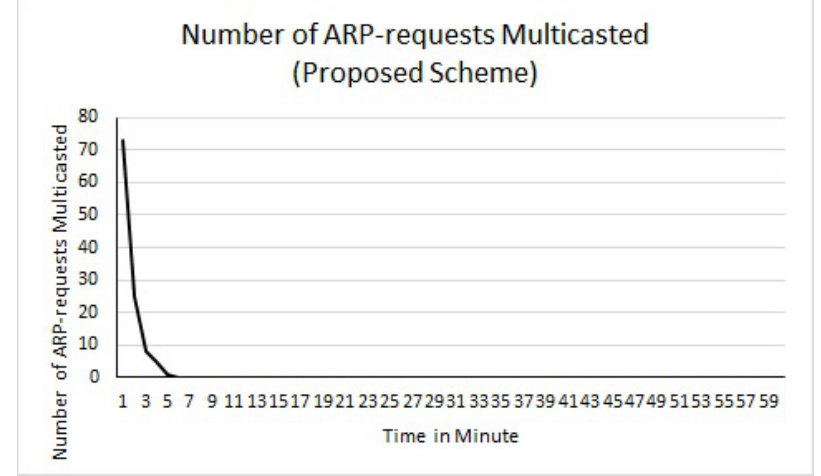
Figure 9. Number of ARP multicasts in